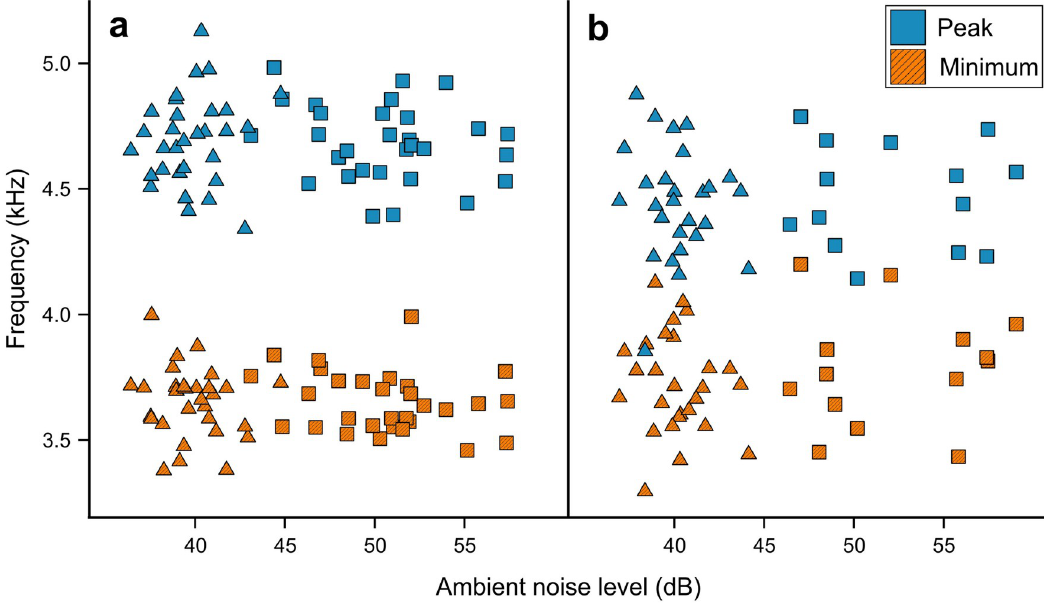
Fig 3. Relationship between the ambient noise level of Common Chiffchaffs (a) and Willow Warblers (b) syllable minimum and peak frequency.